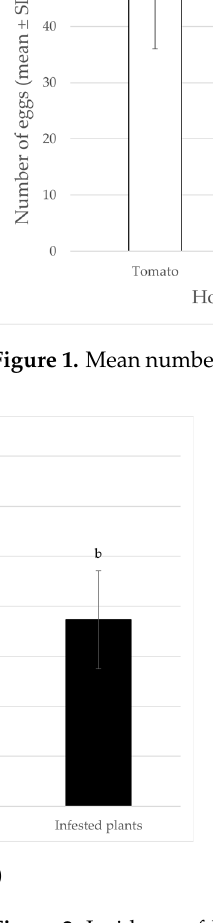
Figure 2. Incidence of B. tabaci infestation on the height ( a ) and shoot dry weight ( b ) of tomato plants. Different letters indicate statistically significant differences at p < 0.01 ( a ) and p < 0.05 ( b ).